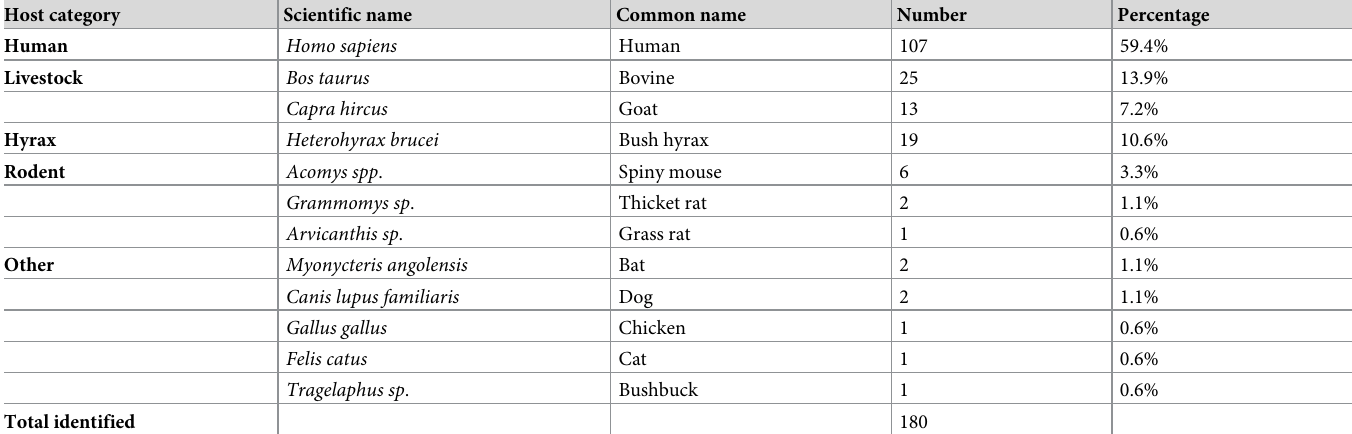
Table 1. Blood meal analysis of Phlebotomus pedifer in Ochollo between February and May 2018. Scientific and common name of blood meal sources grouped into categories for further analysis, and the number and percentage of sand flies that fed on each host. Out of 180 sand flies, 129 were collected indoors, 18 outdoors and 33 inside caves.